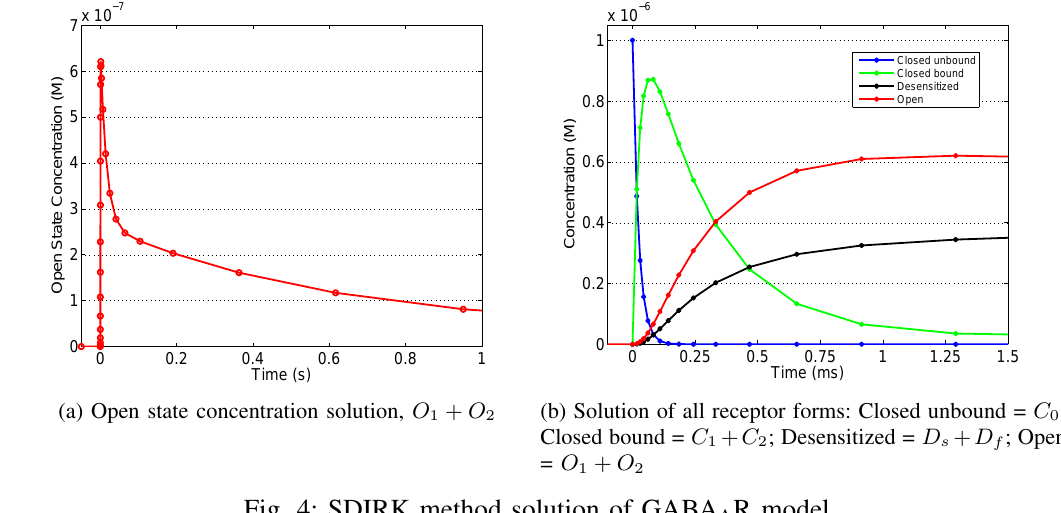
Fig. 4: SDIRK method solution of GABA